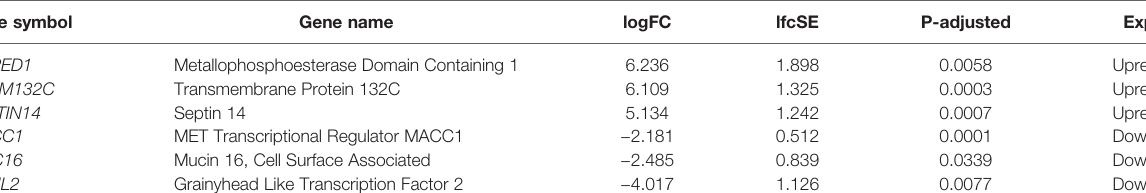
TABLE 2 | Top three differentially expressed genes based on their logFC